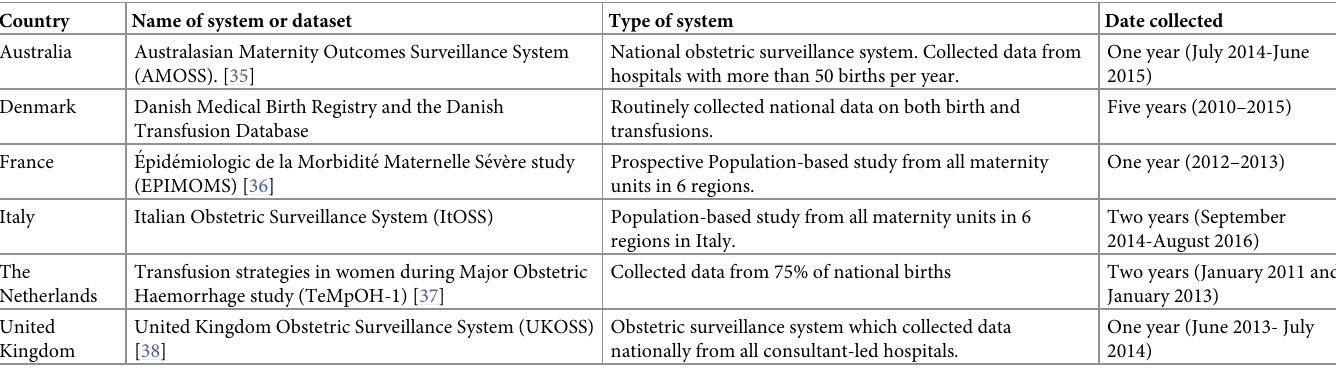
Table 1. Summary of data collection systems and data